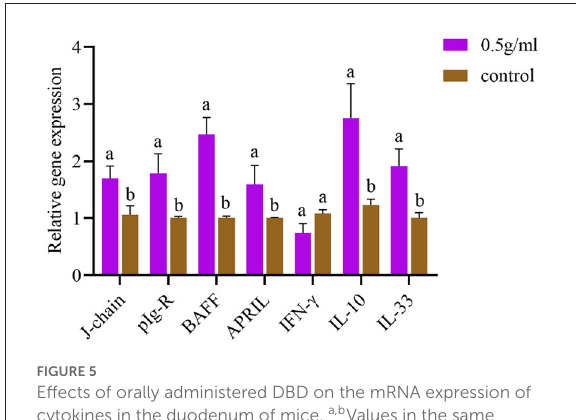
FIGURE5 Effects of orally administered DBD on the mRNA expression of cytokines in the duodenum of mice. a,b Values in the same column with different superscript letters differ significantly at P < 0.05